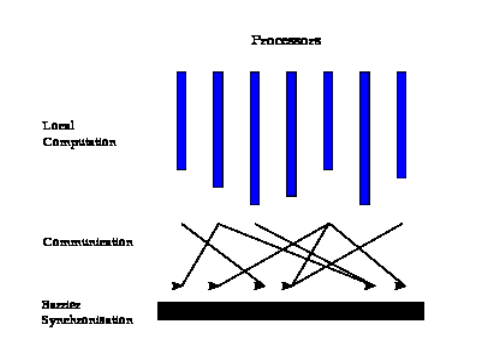
Fig. 2. Three components of a